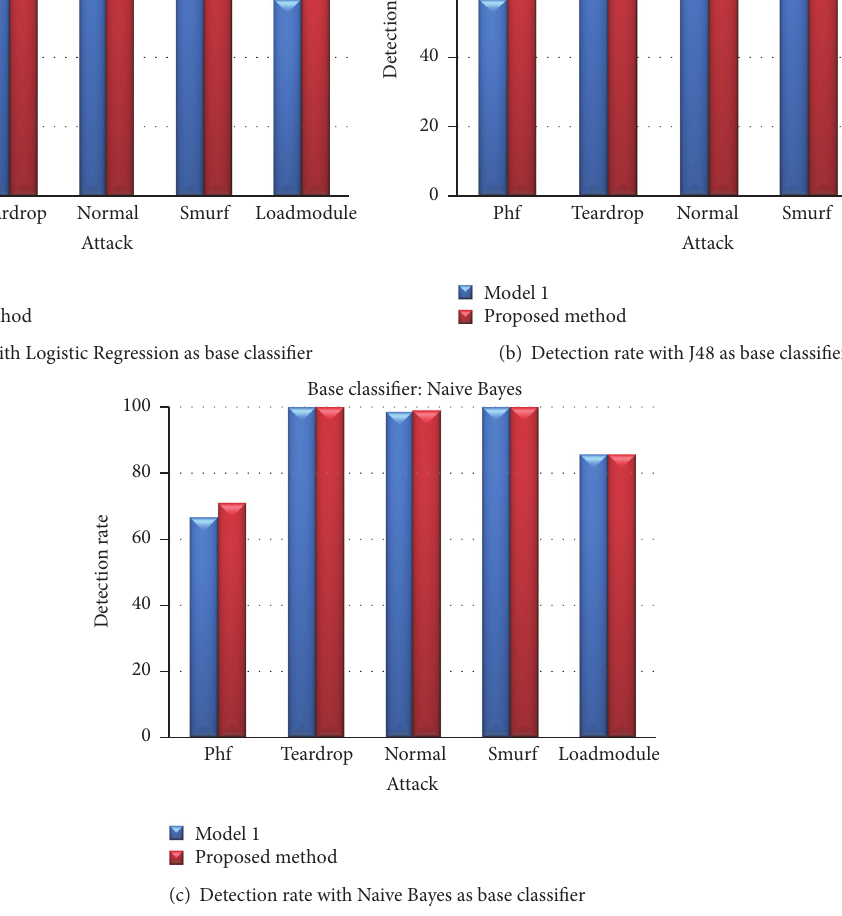
Figure 2: Performance